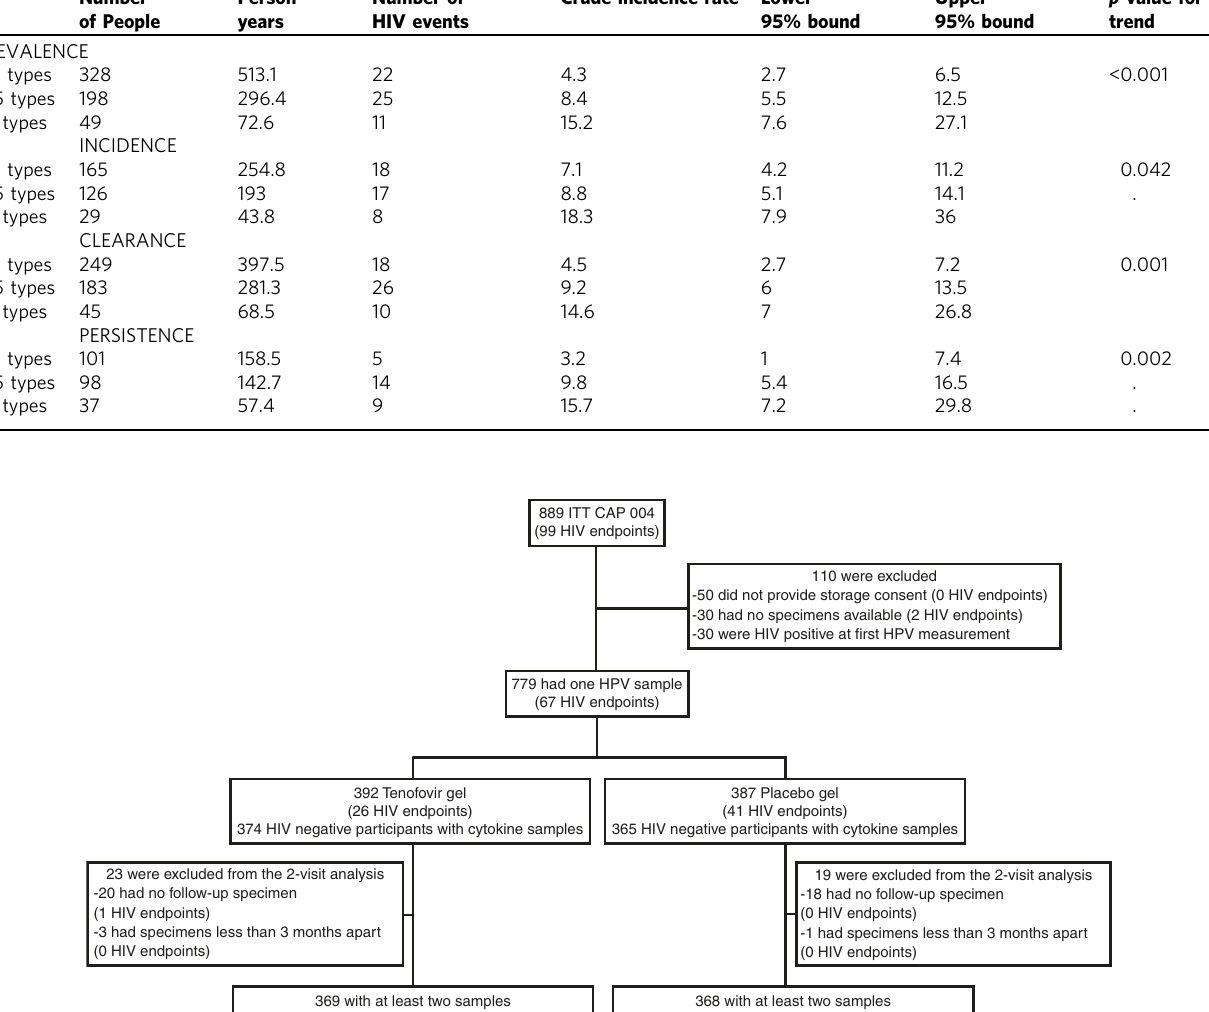
Table 2; Fig. 3; Supplementary Table 2). Similar to our HPV prevalence analysis, HIV risk increased with the number of HPV types that were acquired, cleared and/or that persisted (Table 2). The use of 1% tenofovir gel during the CAPRISA 004 trial 37,40 neither prevented HPV infection nor affected its persistence or clearance (Supplementary Table 3). NATURE COMMUNICATIONS| (2019) 10:5227